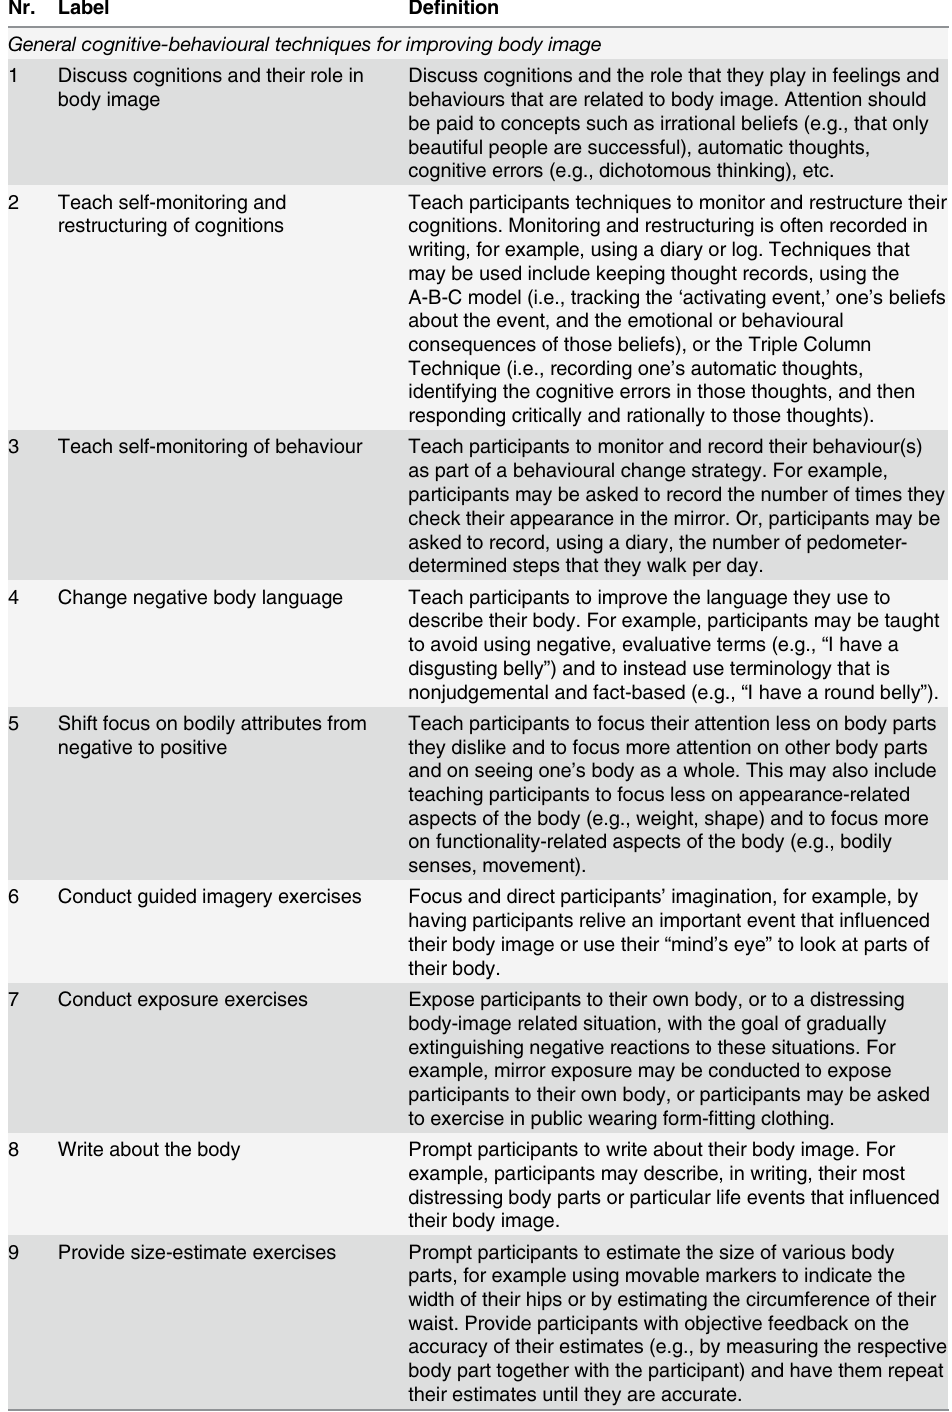
Table 1. Change Techniques Used in Stand-Alone Interventions to Improve Body Image. Nr.